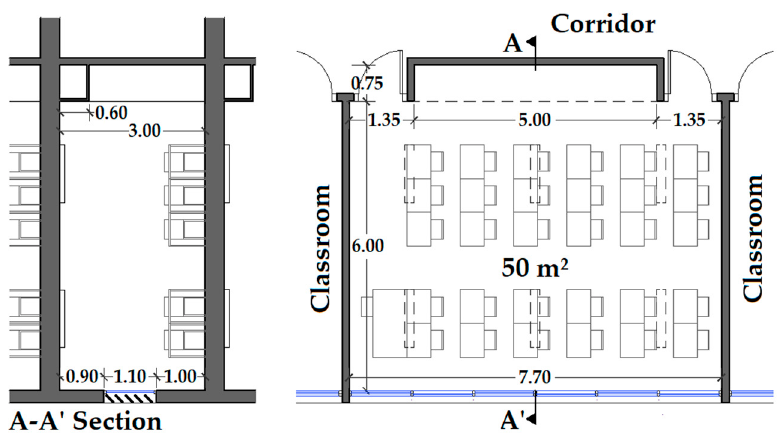
Figure 1. Classroom prototype following design standards for regional educational institutions.